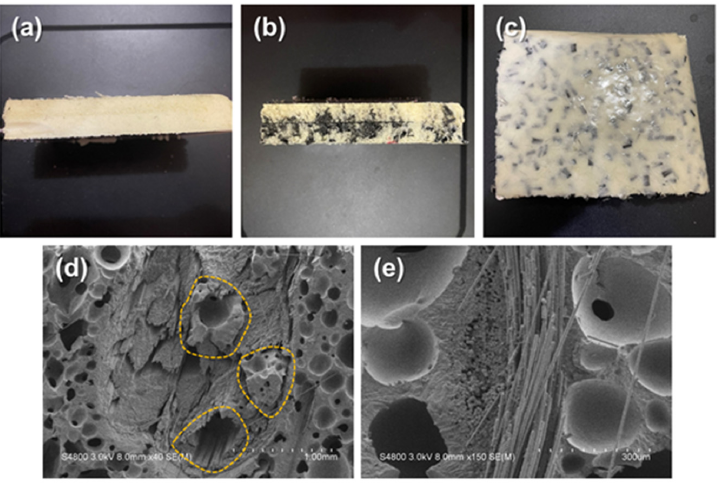
Figure 2. Surface images of ( a ) pure PU foam and ( b ) cutting section, ( c ) the front, and ( d ) interface, and ( e ) magnified interface of composite